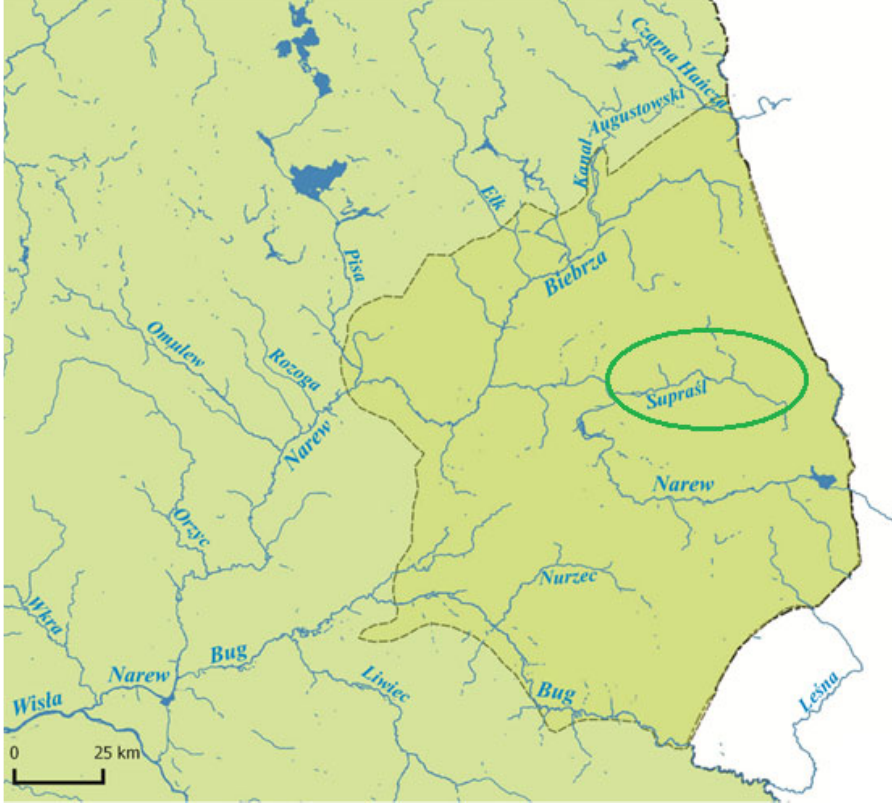
Figure 1. Hydrological location of the study area.